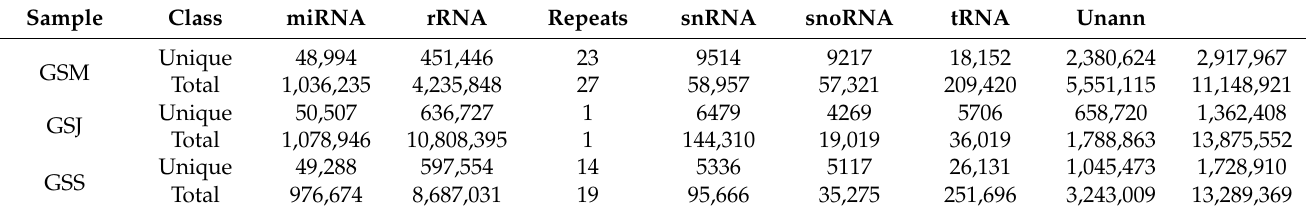
Table 1. Analysis of small RNA sequences from the libraries of Gleditsia sinensis pods at different developmental stages.